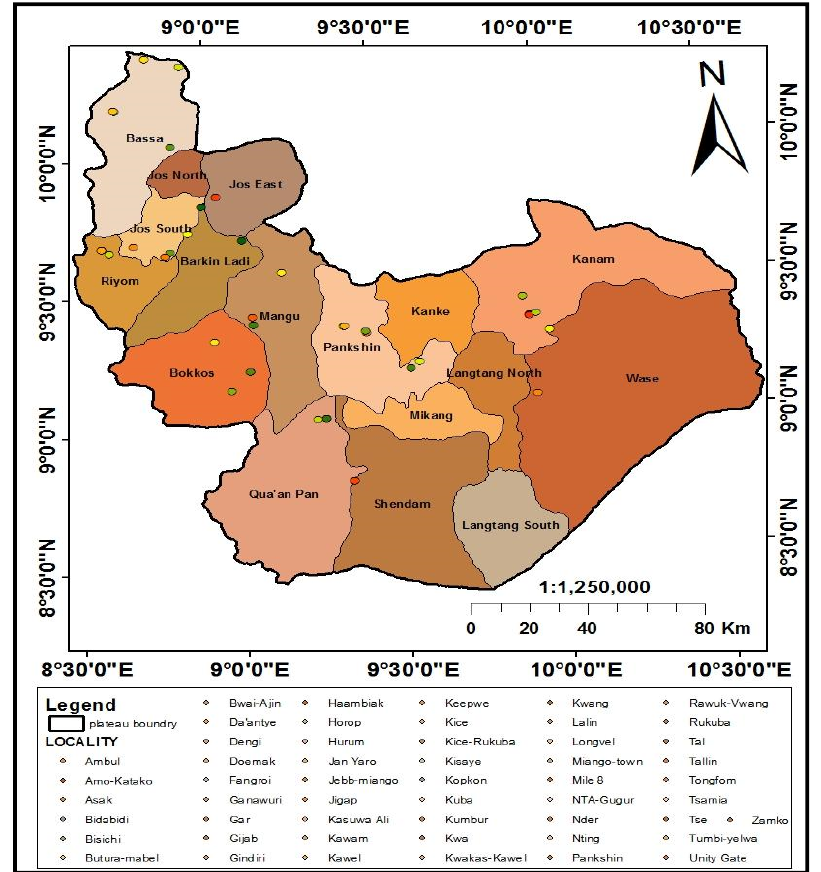
Figure 1. Map of Study Area (Plateau State).